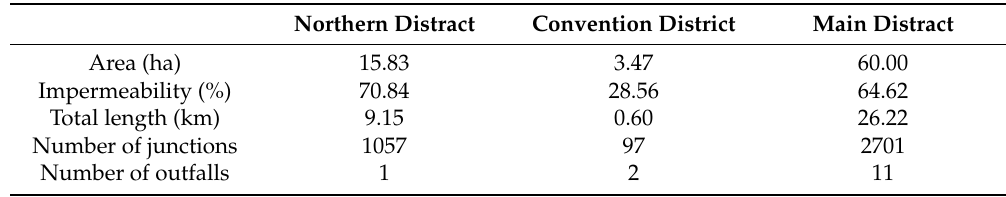
Figure 7. Distribution of the storm sewer networks in the three sub-basins. The red triangles represent outfalls, which are terminal nodes of the drainage system. The blue dots represent junctions where links join together. The light blue line represents conduits that move water from one node to another. Table 1. Properties of the drainage system for the three